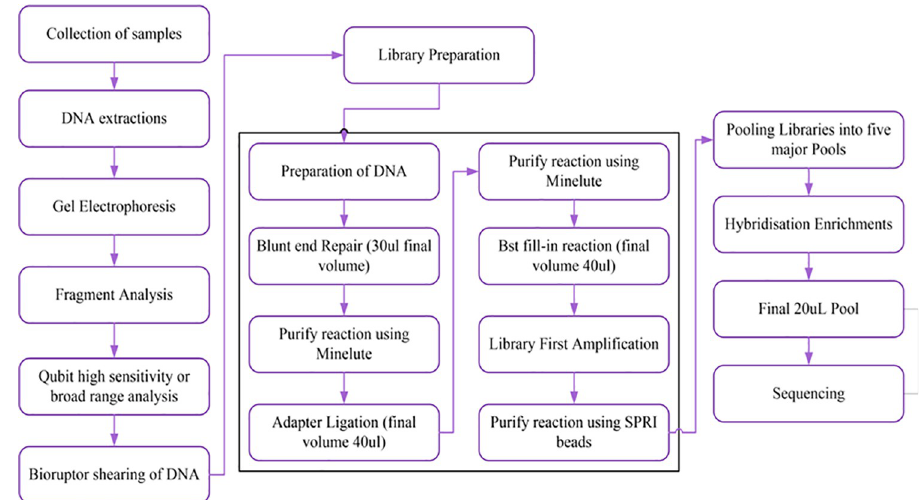
Fig 1. Summary of steps in experimental lab